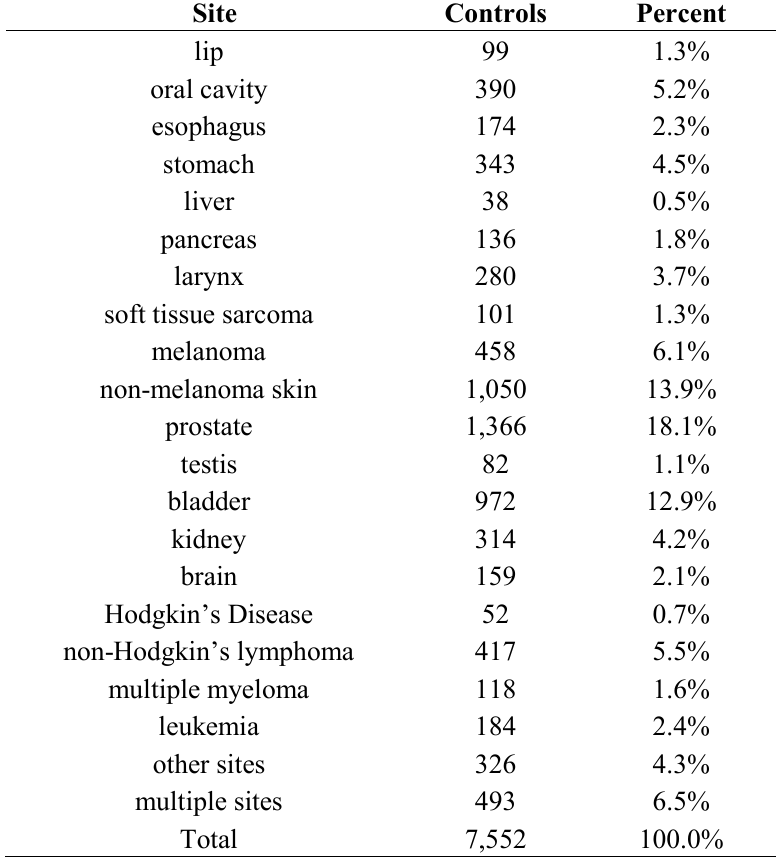
Table 1. Cancer site distribution of 7,552